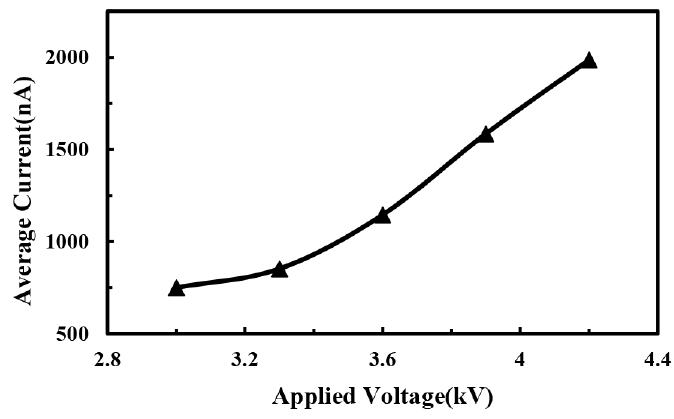
Figure 6. Relationship between average electrohydrodynamic direct-written current and applied voltage. The distance between spinneret and collector, the solution concentration and the solution supply rate were 6 mm, 12%, and 100 µ L/h,